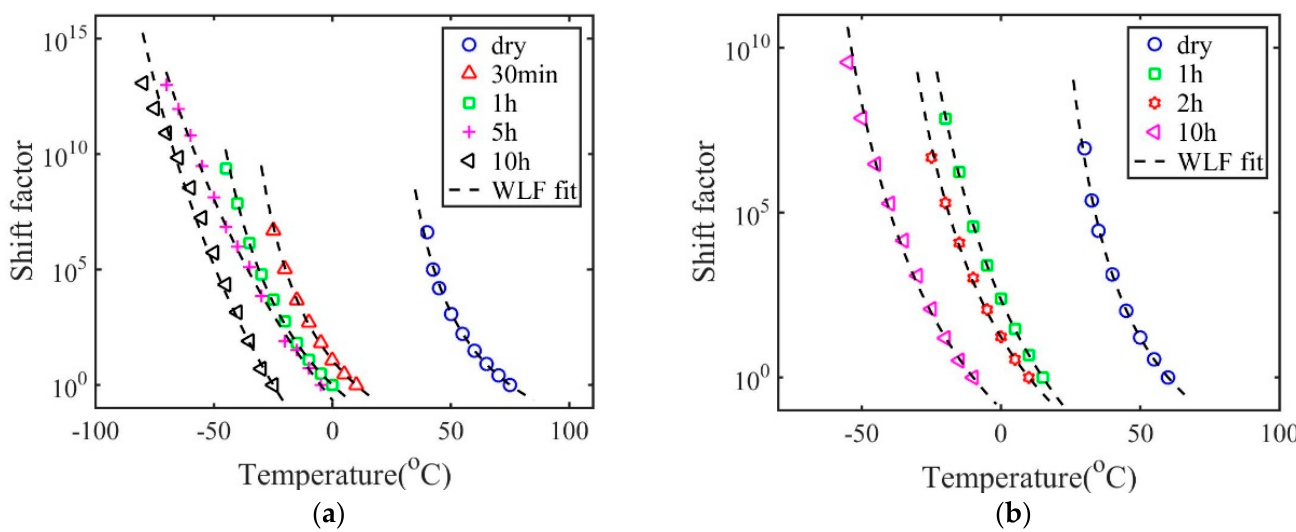
Figure 8. The temperature-dependent shift factor for polymers with ( a ) 2 wt.% and ( b ) 20 wt.% crosslink density.